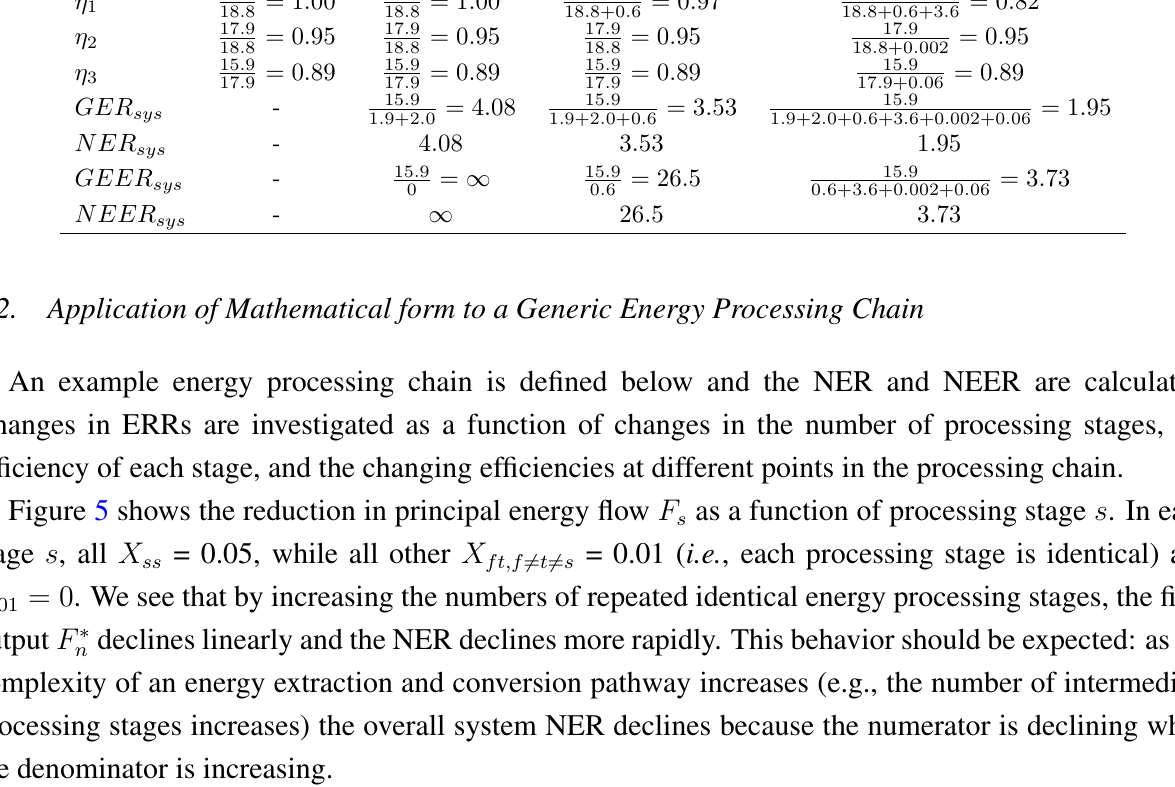
as a function of processing stage s s